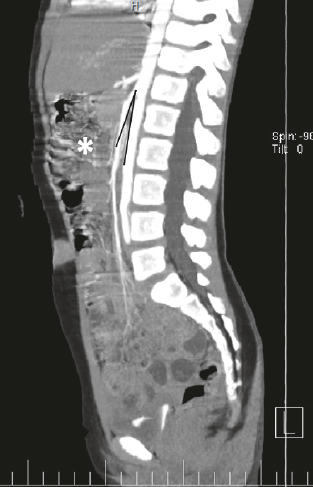
Figure 1: Contrast-enhanced sagittal reconstruction CT scan of superior mesenteric artery (SMA) and its adjacent anatomy shows narrowing of the aortomesenteric angle to less than 15 ∘ and dis- tended stomach ( ∗ ) and full of fluids loops of the small